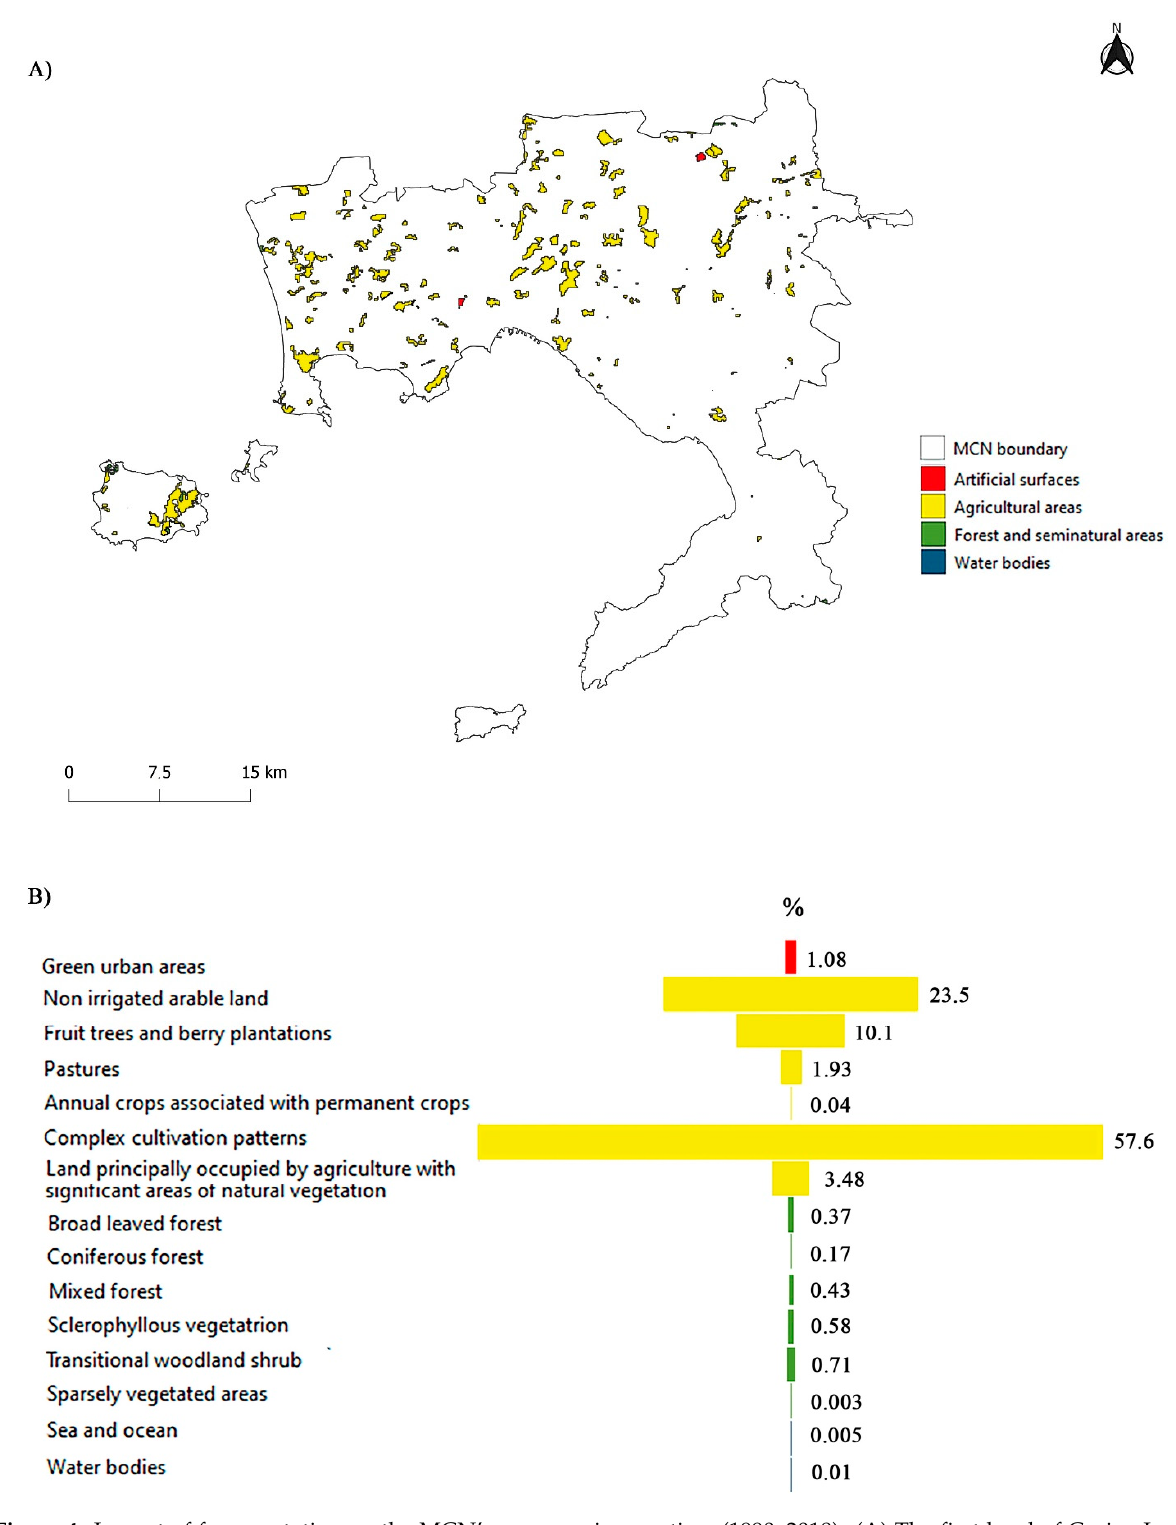
Figure 4. Impact of fragmentation on the MCN’s eco-mosaic over time (1990–2018). ( A ) The first level of Corine Land Cover classification, spatially represented with different colors; ( B ) funnel chart showing the percentage of eroded CLC categories (third level).